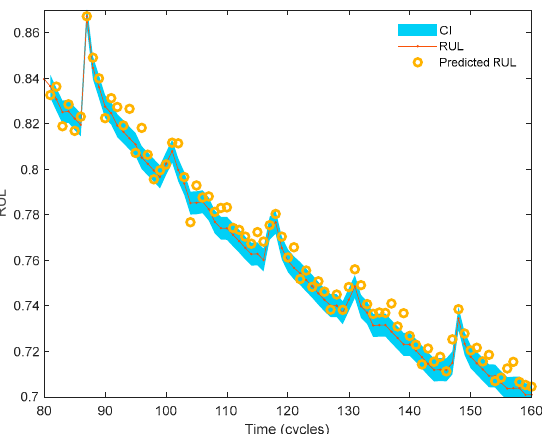
Figure 3. Uncertainty quantification of RUL predictions with a 99% confidence interval.